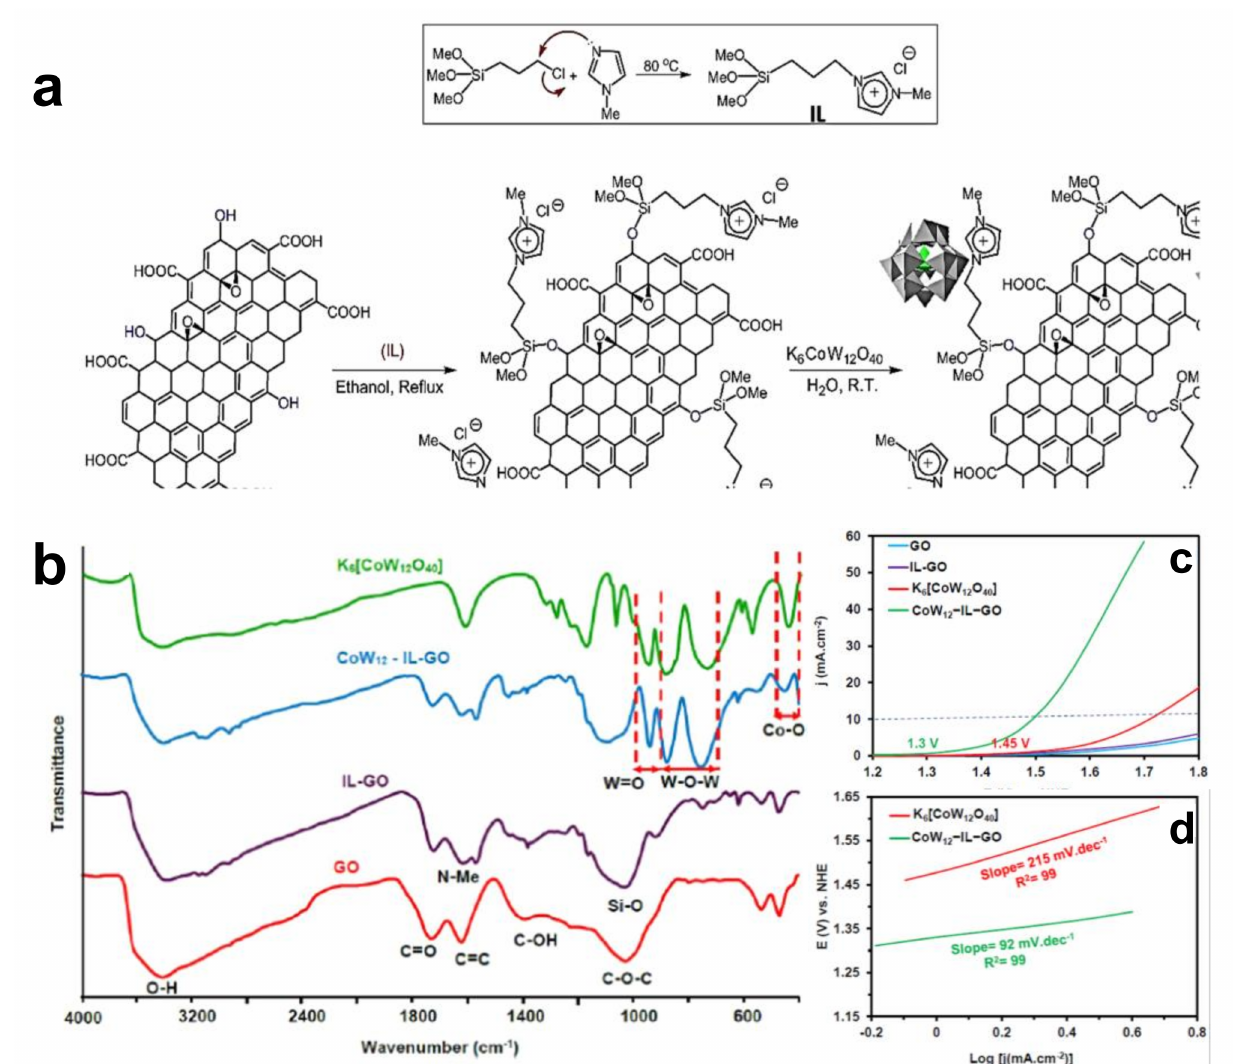
Figure 1. Schematic diagram of preparation of CoW 12 − IL − GO hybrid nanomaterials. ( a ) FT − IR spectra of CoW 12 − IL − GO and control samples; ( b ) OER polarization curves; ( c ) and Tafel slopes ( d ) of CoW 12 − IL − GO and control samples. Reprinted with permission from ref. [48], copyright 2022